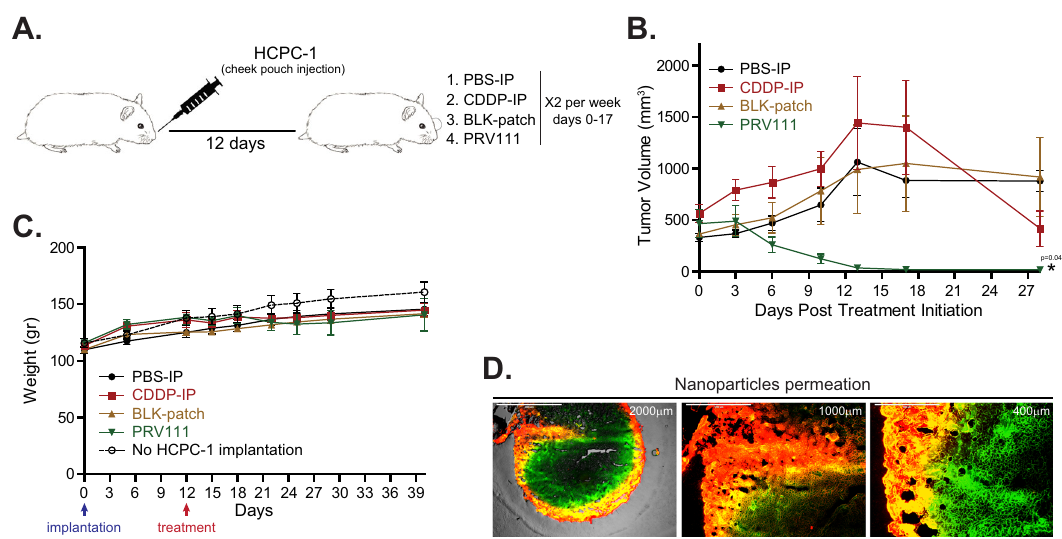
Fig. 2 Local application of PRV111 induced robust anti-tumor response in hamster orthotopic oral cancer model. A Schematic representation of the experiment. B Golden Syrian hamsters bearing orthotopic tumors induced by injection of HCPC-1 cell line into the cheek pouch were treated with either PBS-IP, CDDP-IP, BLK-patch or PRV111. Graphs show the average tumor volume for 6 animals per group ± SEM. P -value was performed by a 1-sided Wilcoxon Rank-sum method. Asterisk represents statistical signi fi cance between the CDDP-IP and PRV111 groups ( p < 0.05). C Graph shows the average body weights for 6 animals per group ± SEM. Body weights of 5 tumor free animals without treatment were measure along the tumor bearing counterparts (dashed line). D Representative fl uorescence images of tumor sections at indicated magni fi cation taken after treatment of the hamster with PRV111 patch containing chitosan particles labeled with Cy5 (red) and encapsulating FITC (green). Yellow areas display dual-labeling, NPs with encapsulated FITC. Permeation experiment was repeated in 6 tumors. Source data are provided as a Source Data fi